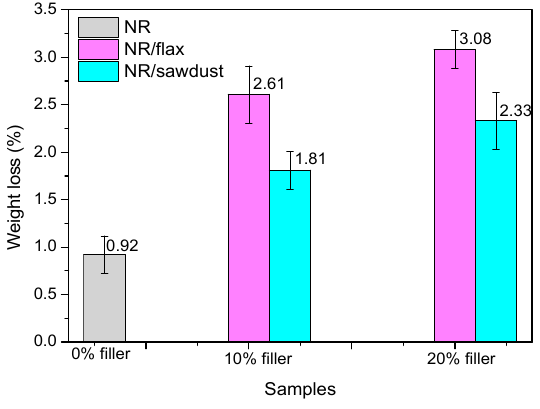
Figure 3. Weight loss of the composites.